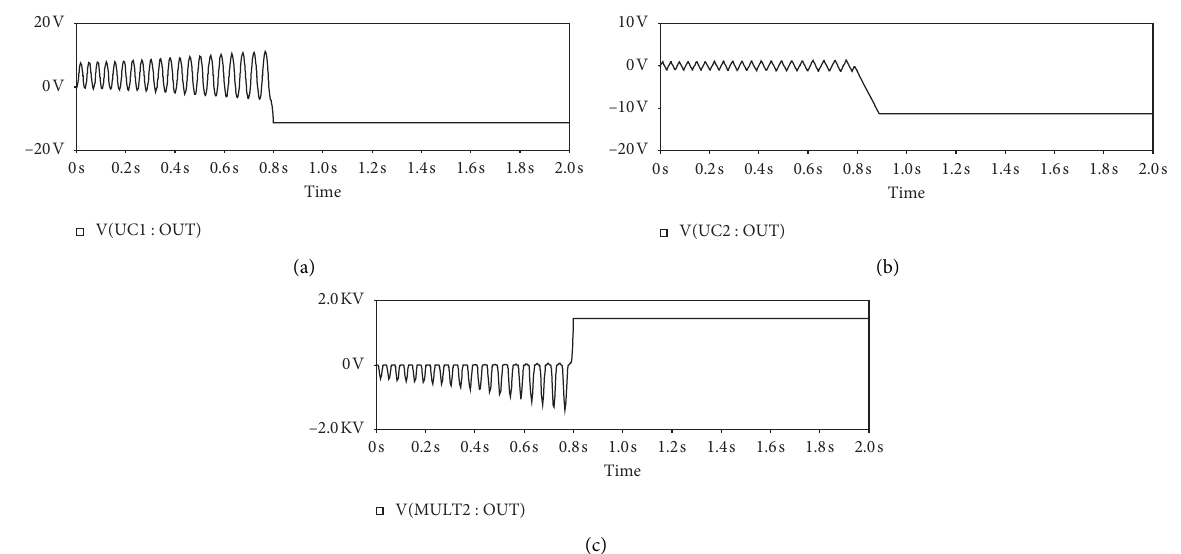
, (b) amplifier with capacitor C